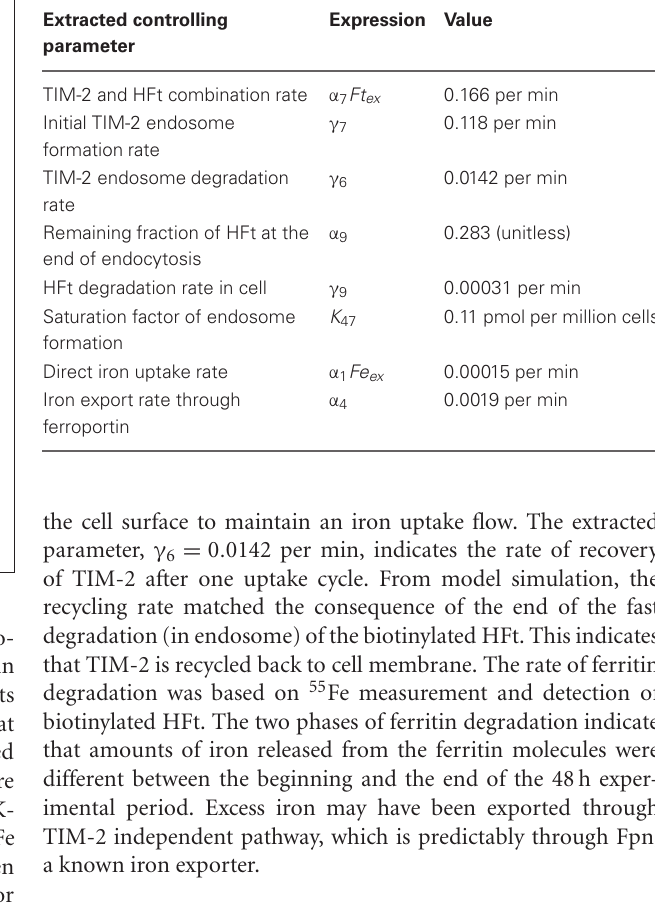
Table 1 | Extracted controlling parameters of TIM-2 pathway